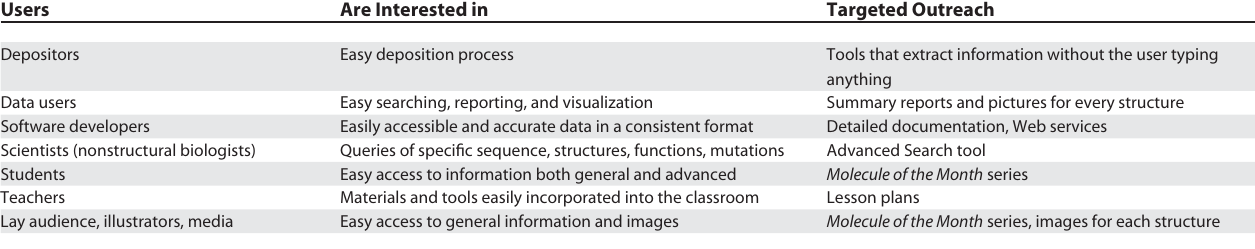
Table 1. Selected Examples of RCSB PDB Users and Ongoing Outreach